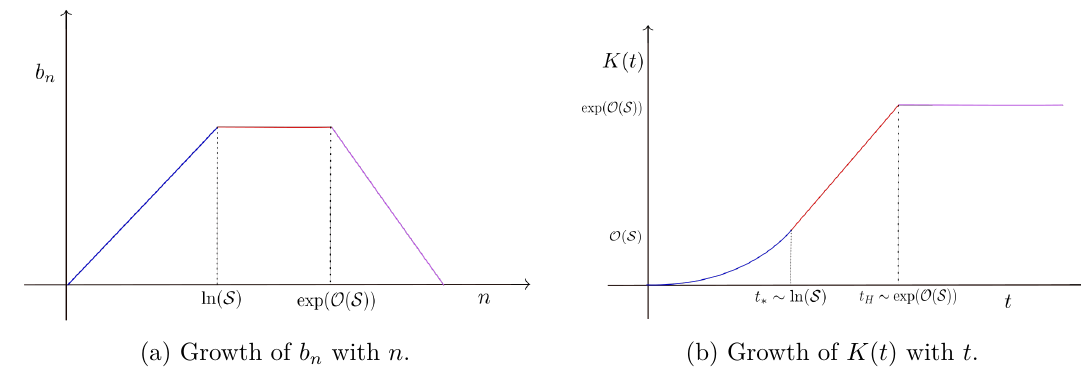
Figure 1. A rough sketch of the behavior of Lanczos coefficients b n with n for a “chaotic” system. The linear increase (blue) of Lanczos coefficients corresponds to the exponential growth of K- complexity K ( t ) up to the time-scale t = ln S . After that, b saturates to some constant (red), ∗ n which corresponds to the linear increase of K-complexity. Finally, the decrease of b (purple) is the n Lanczos descent which marks the saturation of